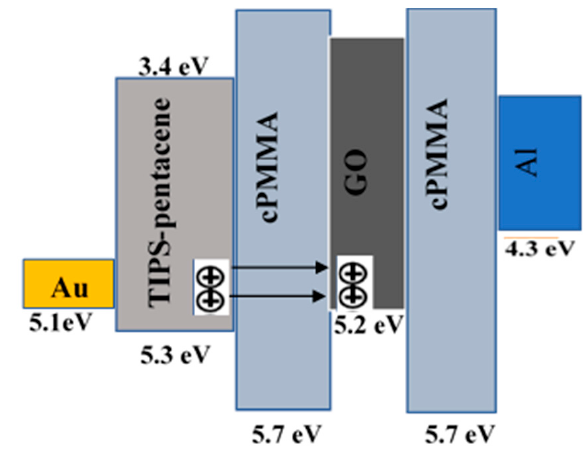
Figure 9. Schematic diagram of the energy band for the OTFMT.